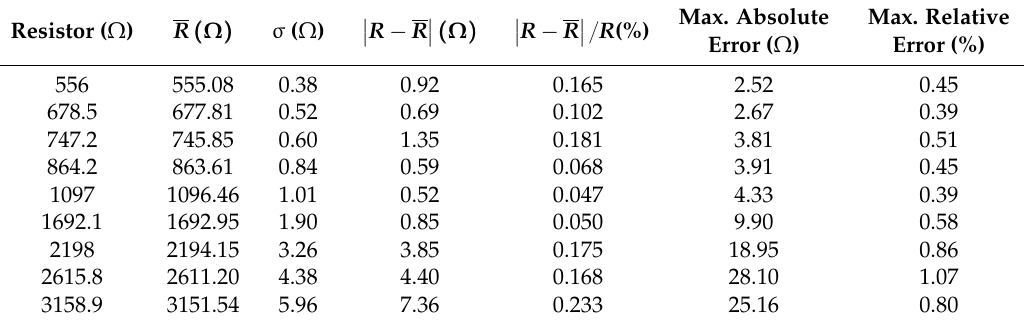
Table 3. Accuracy data for R ij estimation by using Equation (22) R P r 556 Ω ,3159 Ω s .